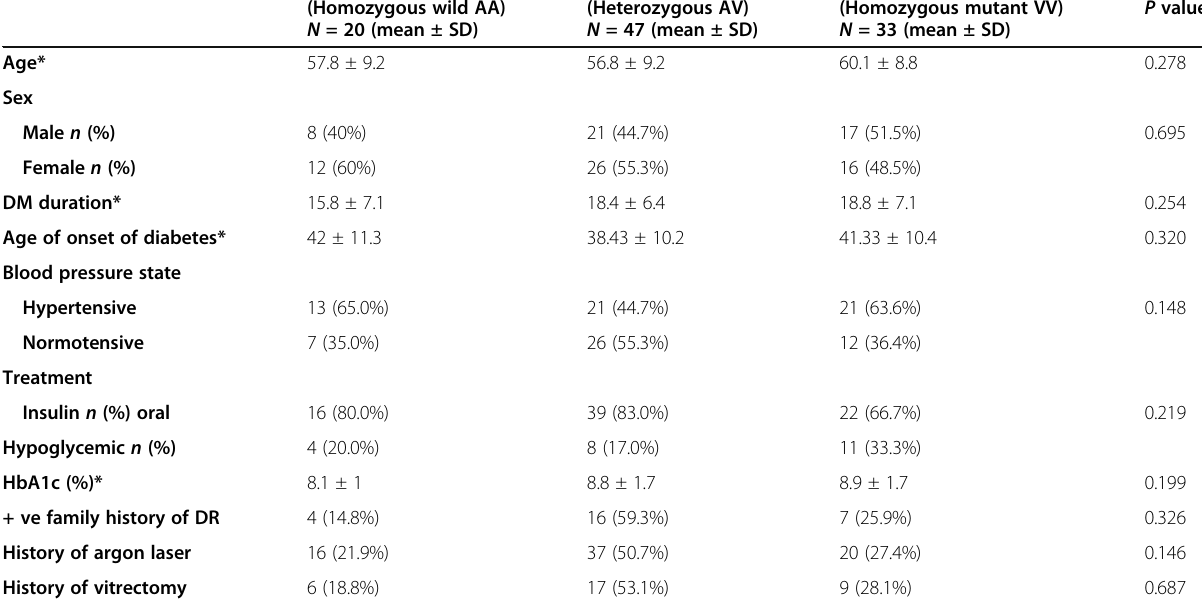
Table 3 The demographic, clinical, and laboratory data of the homozygous mutant, heterozygous, and wild genotype groups among the DR